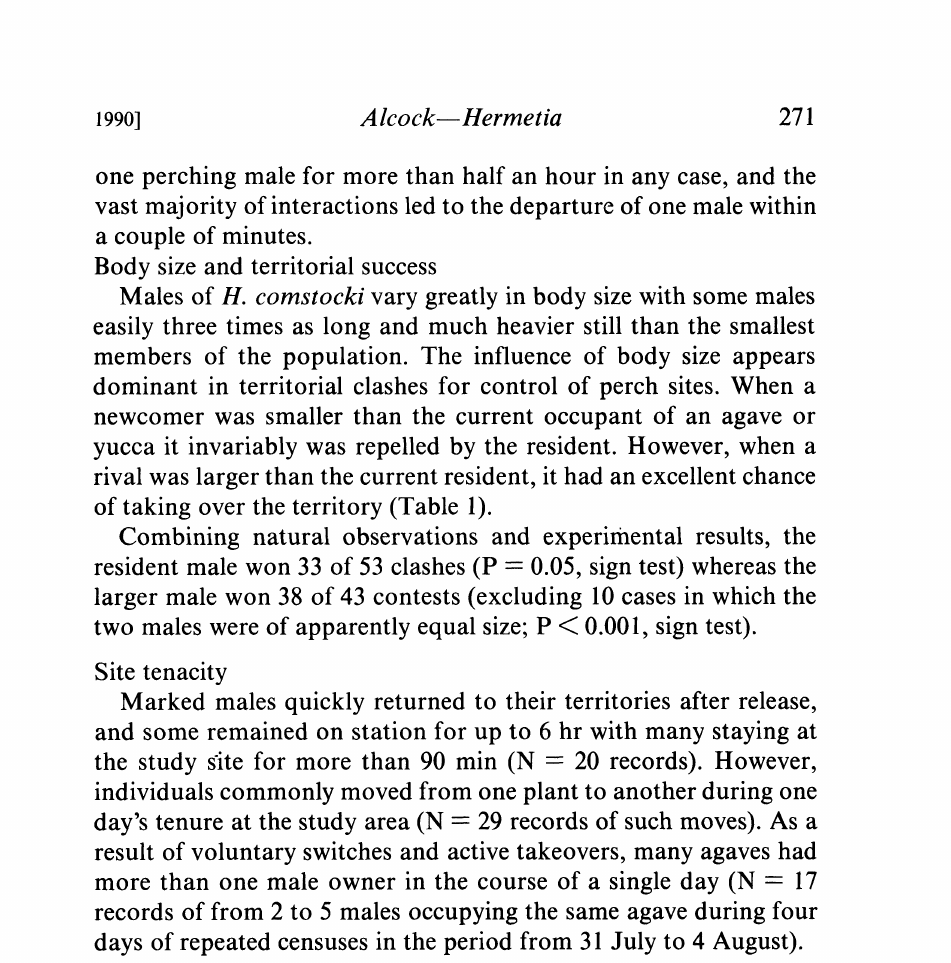
Table 1. The significance of body size in determining winners in territorial contests between males of Hermetia comstocki in natural (nonmanipulated) encounters and experimental encounters, in which a captured male was transferred to and released at an occupied